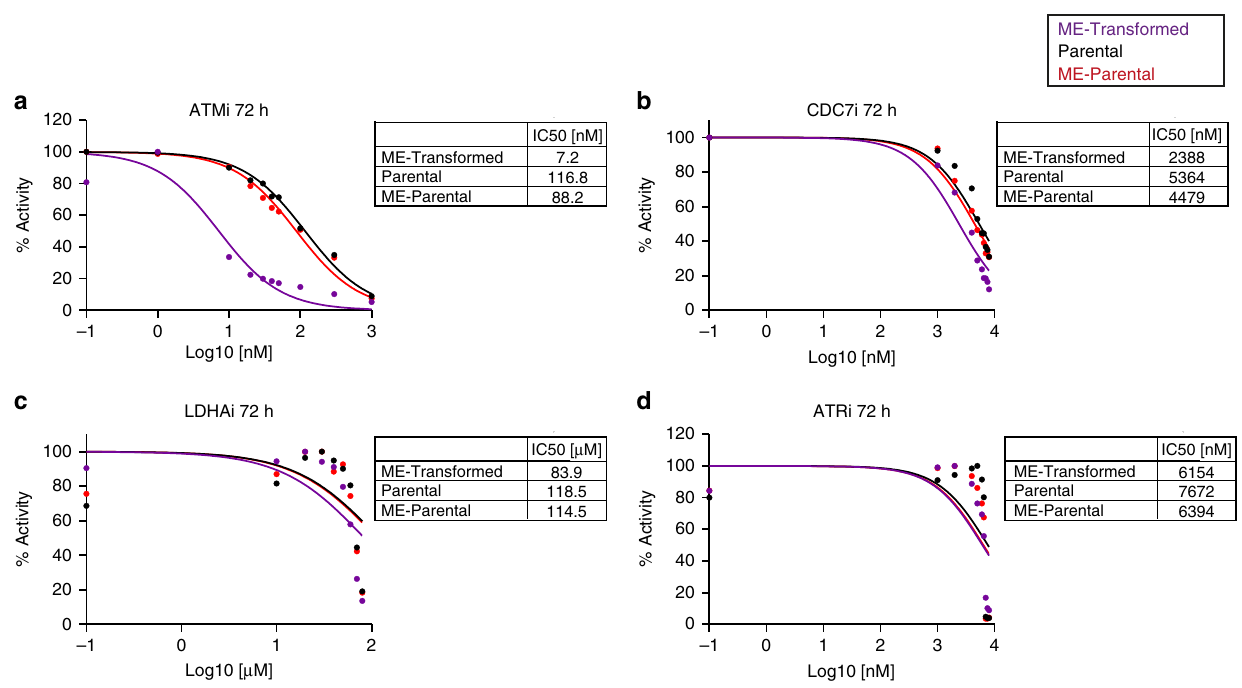
Fig. 6 ATMi, CDC7i, LDHAi and ATRi treatments validate the genome-wide CRISPR screen. a – d Plots showing IC50 fi tting curves and IC50 values at 72 h post treatment of Parental, ME-Parental (cultured in presence of Flt3L and β -estradiol) and ME-Transformed (cultured in the presence of IL-3) with inhibitors against ATM ( a ), CDC7 ( b ), LDHA ( c ) and ATR ( d ). Data are shown as mean of biological replicates; N = 2 biologically independent experiments. Source data are provided as a Source Data fi